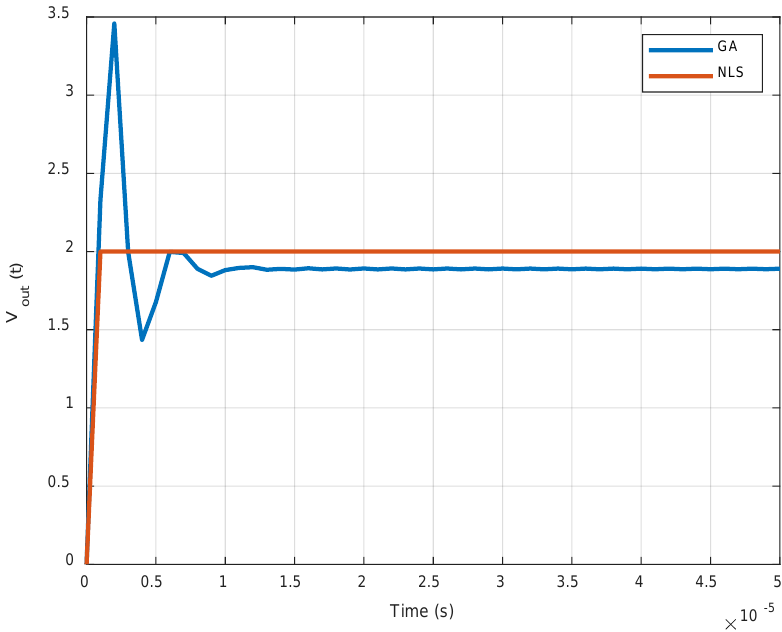
Figure 11. Bode plot of the unoptimized and optimized